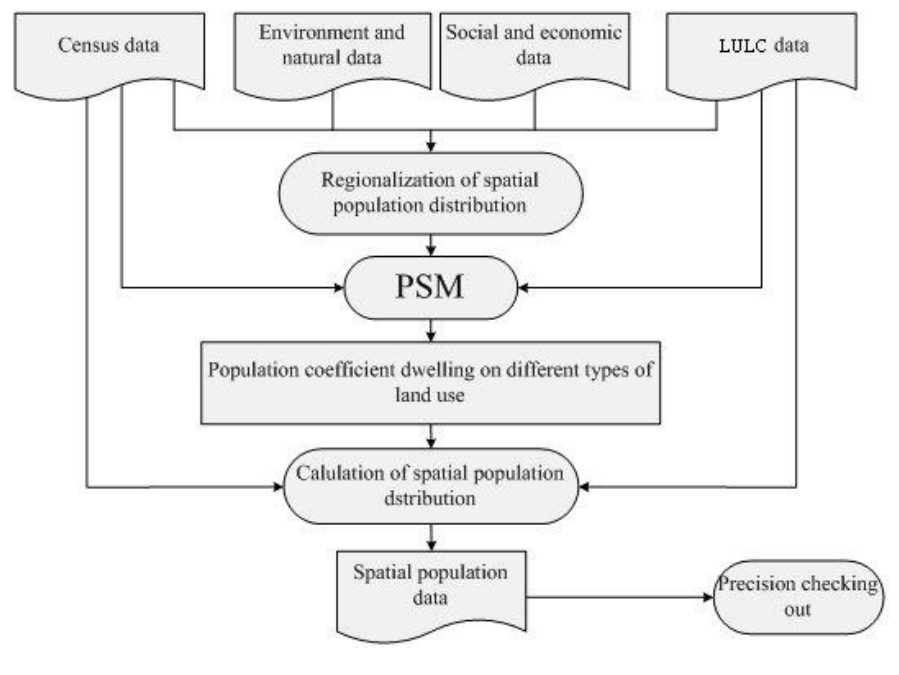
Figure 1. Flowchart for producing Gridded Population Dataset of